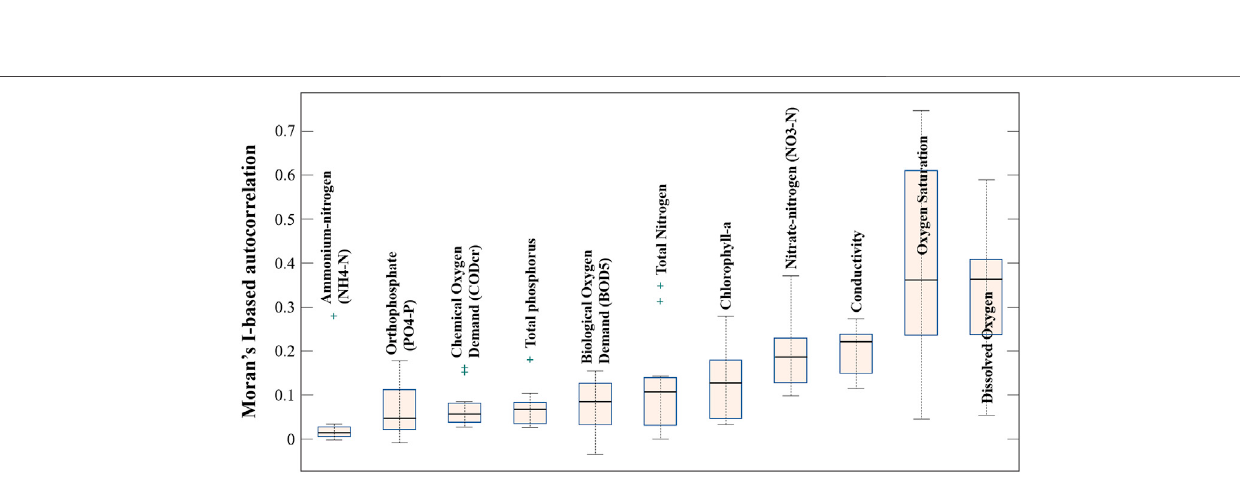
FIGURE 7 | The Moran ’ s I neighbouring dependence of the water quality parameters of Hungarian water bodies. Higher values indicate higher global spatial autocorrelation.